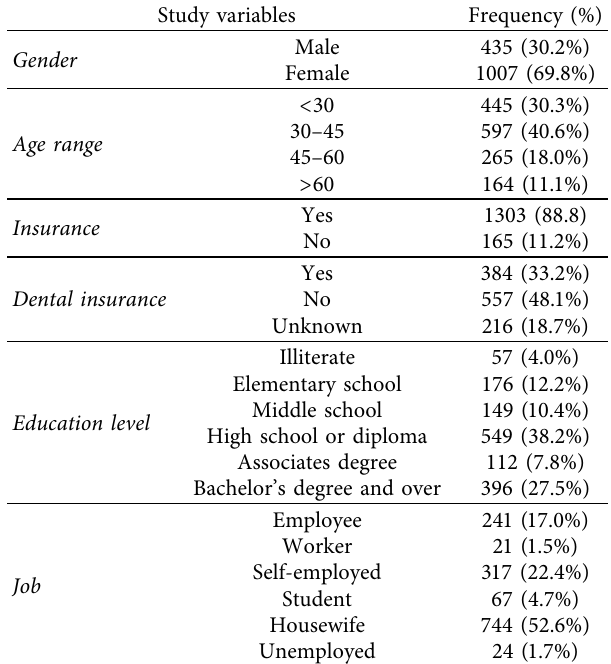
Table 1: Sociodemographic characteristics of the study population. Study variables